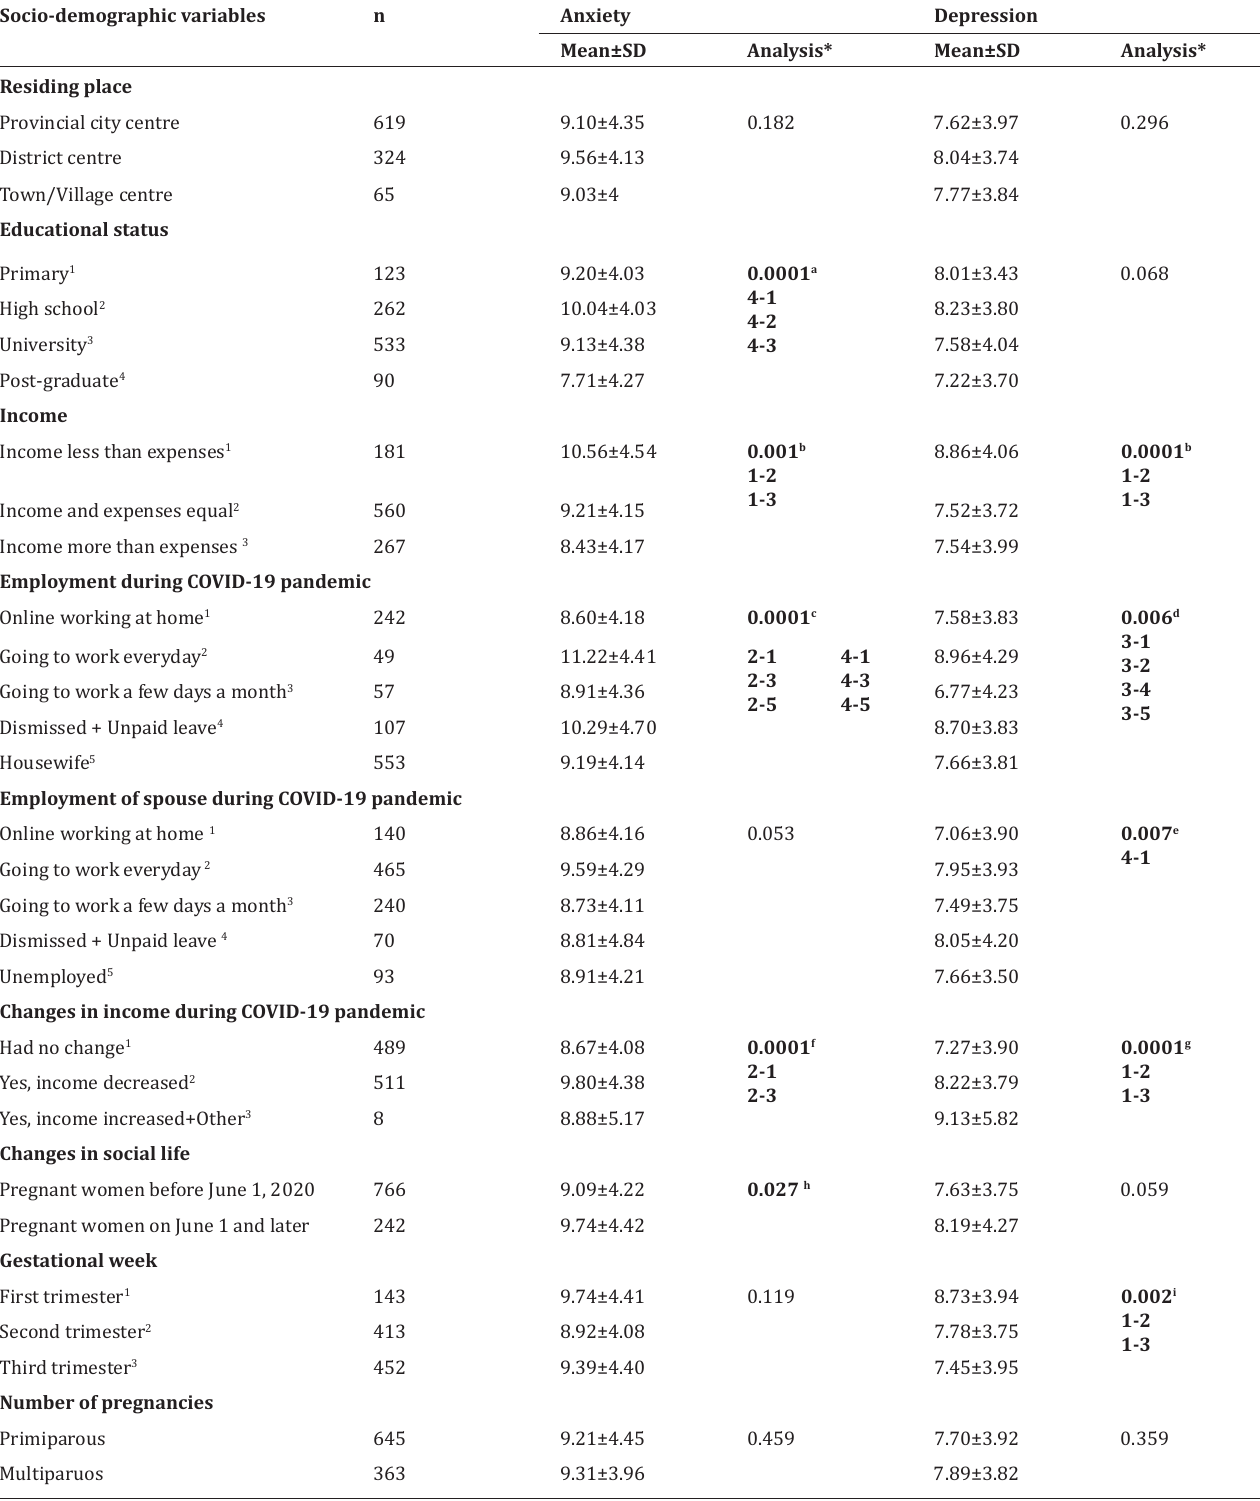
Distribution of anxiety and depression scores according to some sociodemographic and obstetric characteristics of pregnant women Socio-demographic